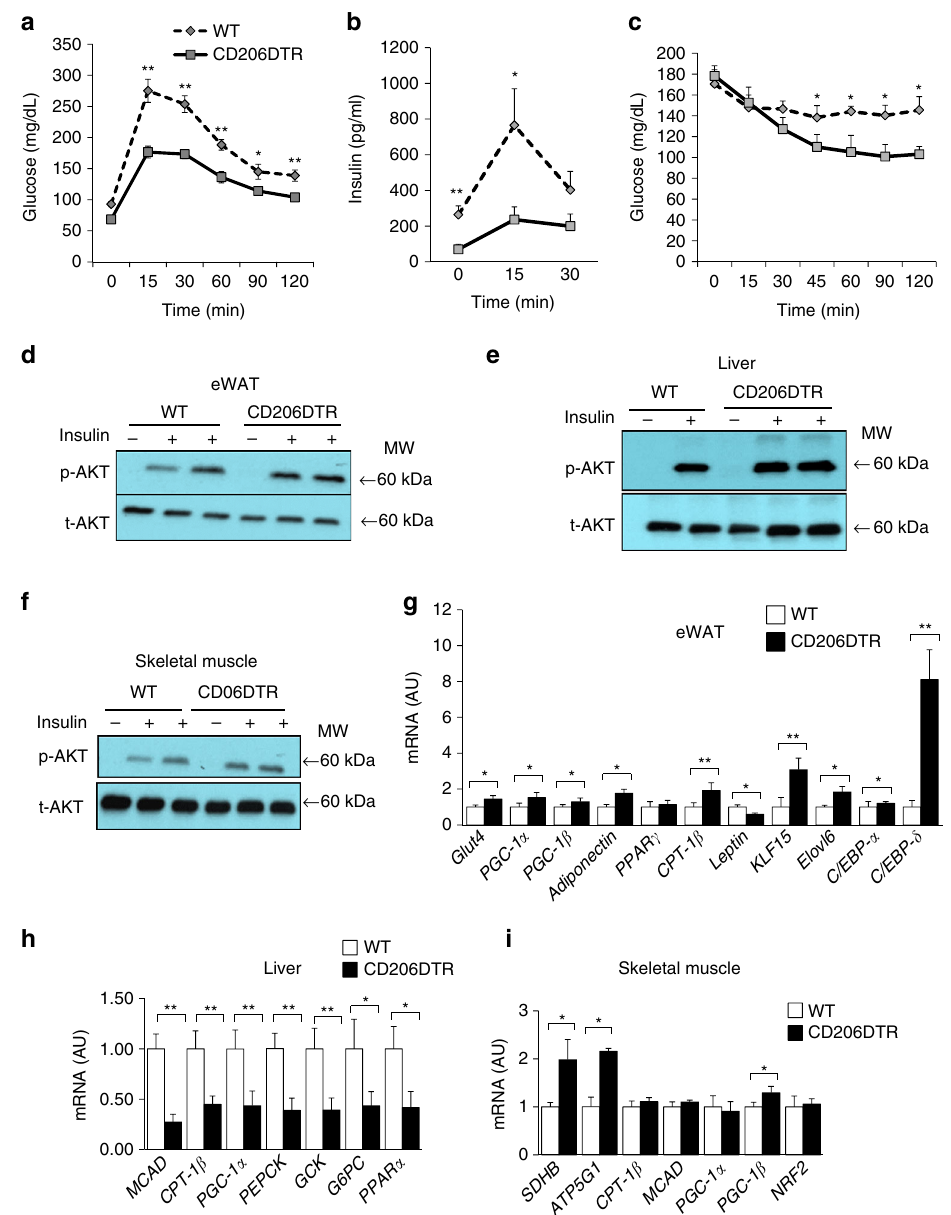
Fig. 7 CD206 + M2-like ATMs depletion promote insulin sensitivity in lean mice. a , b Glucose and insulin concentrations in an intra-peritoneal glucose tolerance test (IP-GTT), and c the glucose concentrations in an intra-peritoneal insulin tolerance test (IP-ITT) in NC-fed mice after DT treatment ( n = 4 – 6 per group). d – f Western blot analysis of Akt phosphorylation in the eWAT, liver and skeletal muscle of DT-treated CD206DTR and WT littermates. (MW = Molecular weight). g Relative mRNA expression of mitochondrial, smaller adipocytes and adipogenesis marker genes in the eWAT ( n = 3 – 5 per group). h Relative mRNA expression of gluconeogenesis and fatty acid oxidation genes in the liver and i skeletal muscle ( n = 3 – 5). The data are shown as the means ± SEM. * P < 0.05, ** P < 0.01 compared with littermates by Student ’ s t